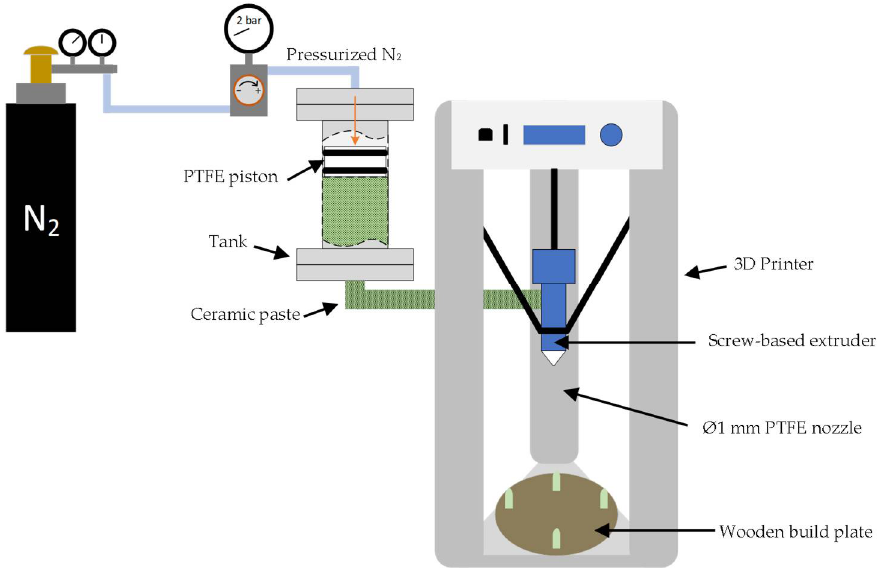
Figure 1. Schematic representation of the experimental setup used for 3D printing.